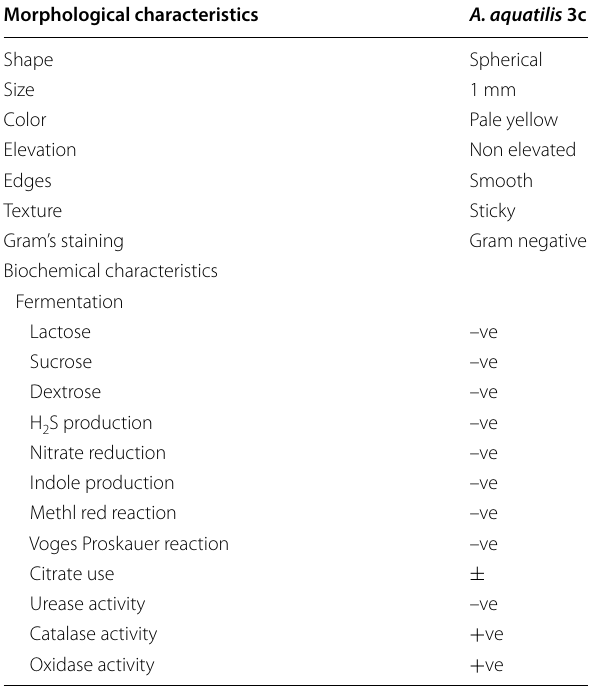
Table 1 Morphological and biochemical characteristics of A. aquatilis